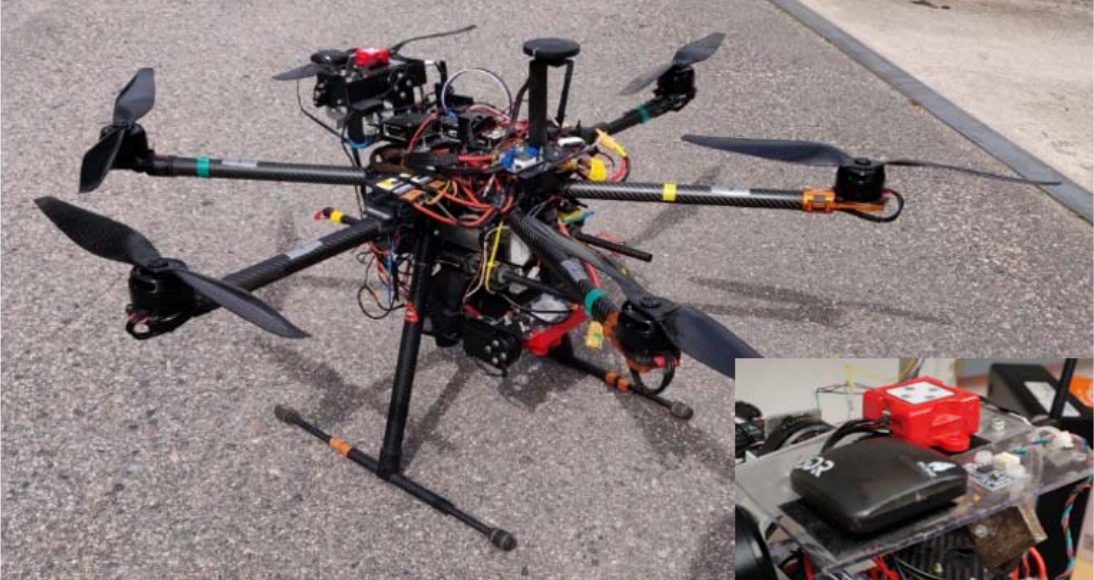
Figure 1. Custom-built drone with a Tarot T960 frame. The multispectral camera light sensor had a separate gimbal (small figure). This solution minimizes disturbances that are caused by shadows forming on the sensor when the drone is flying away from the sun.